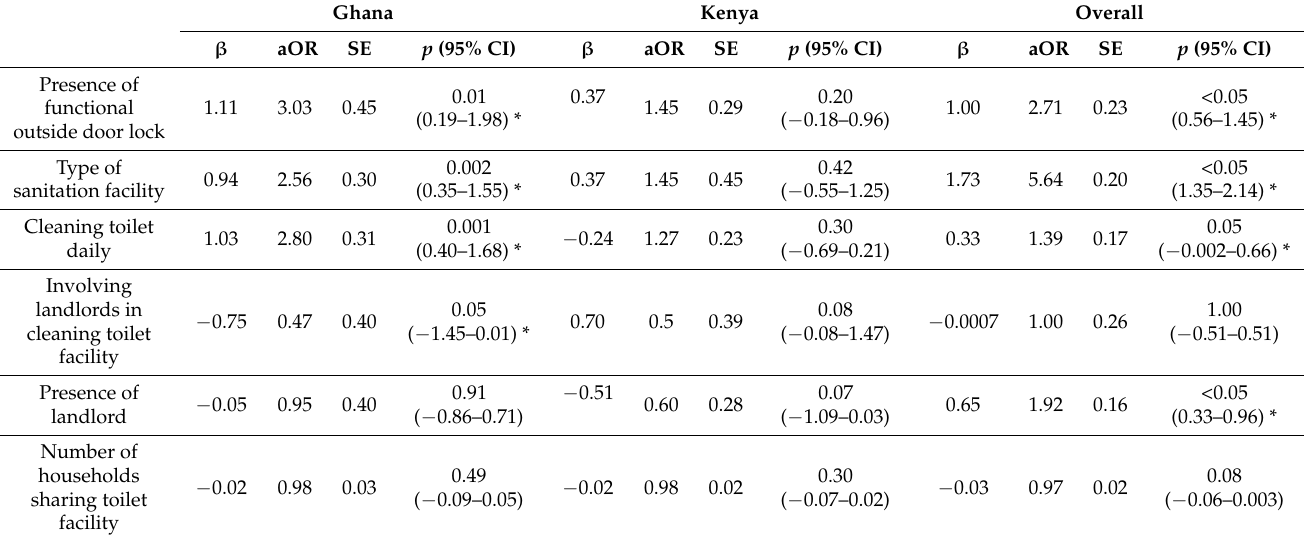
Table 4. Predictors of the cleanliness of shared sanitation